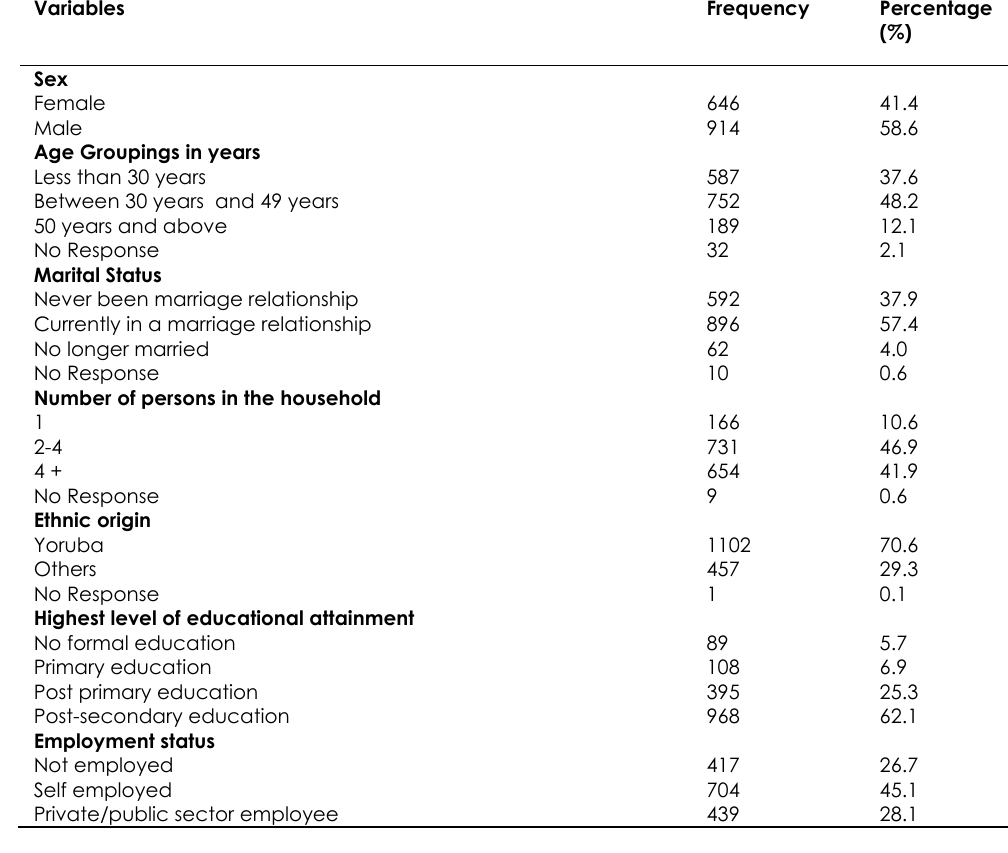
Table 1. Demographics of the